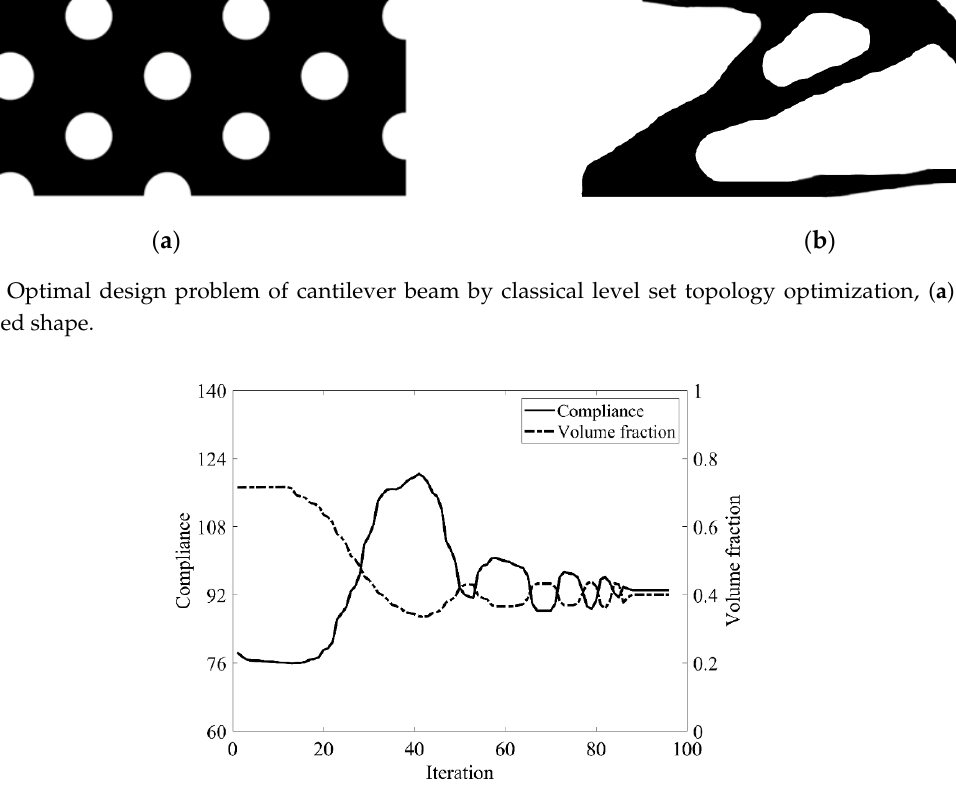
Figure 24. Convergence history of the compliance and the volume fraction for cantilever beam by classical level set topology optimization.